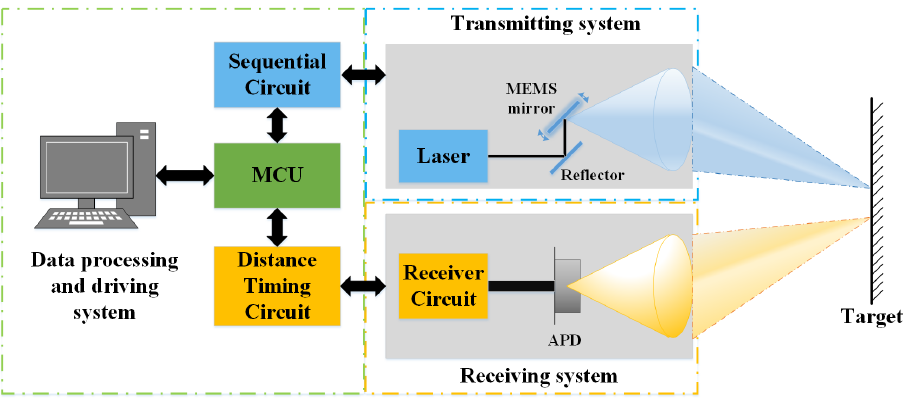
Figure 1. Schematic diagram of the pulsed LiDAR